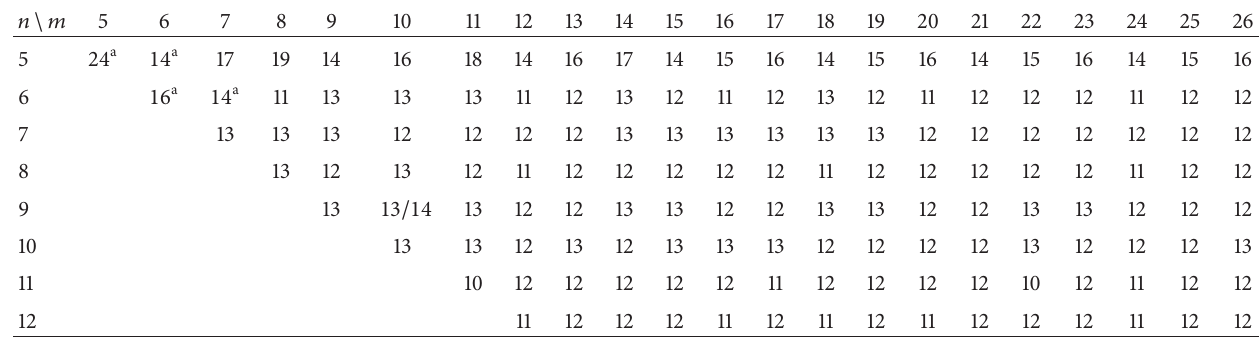
Table 2: Values of 𝜆(𝐶 𝑛 ⊠ 𝐶 𝑚 )